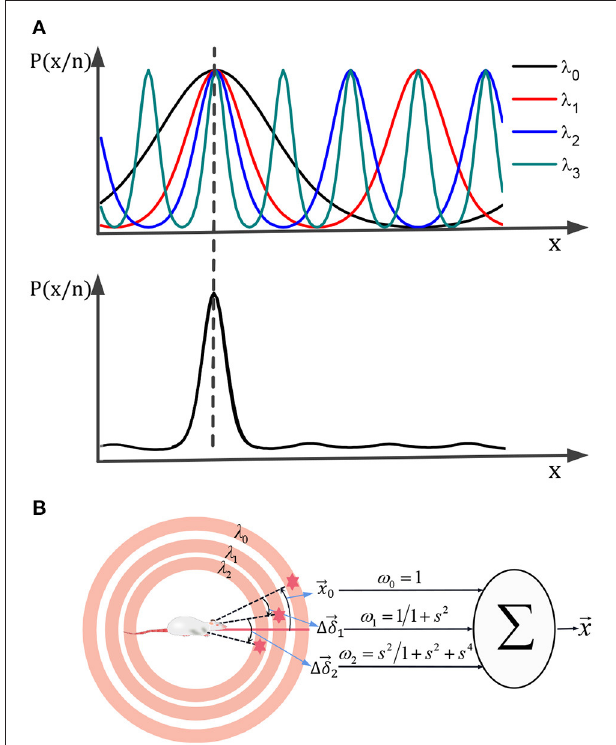
FIGURE 7 | A unique high-precision solution can be obtained by calculating the joint distribution of the posterior probability of each scale grid neural plate (A) . (B) The multi-scale decoding could be calculated by the weighted sum of the